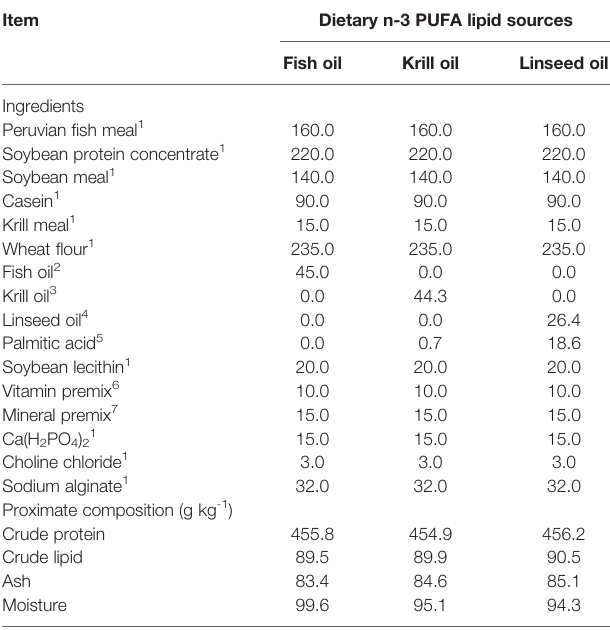
TABLE 1 | Formulation and analyzed proximate composition of experimental diets (g kg -1 , DM basis).